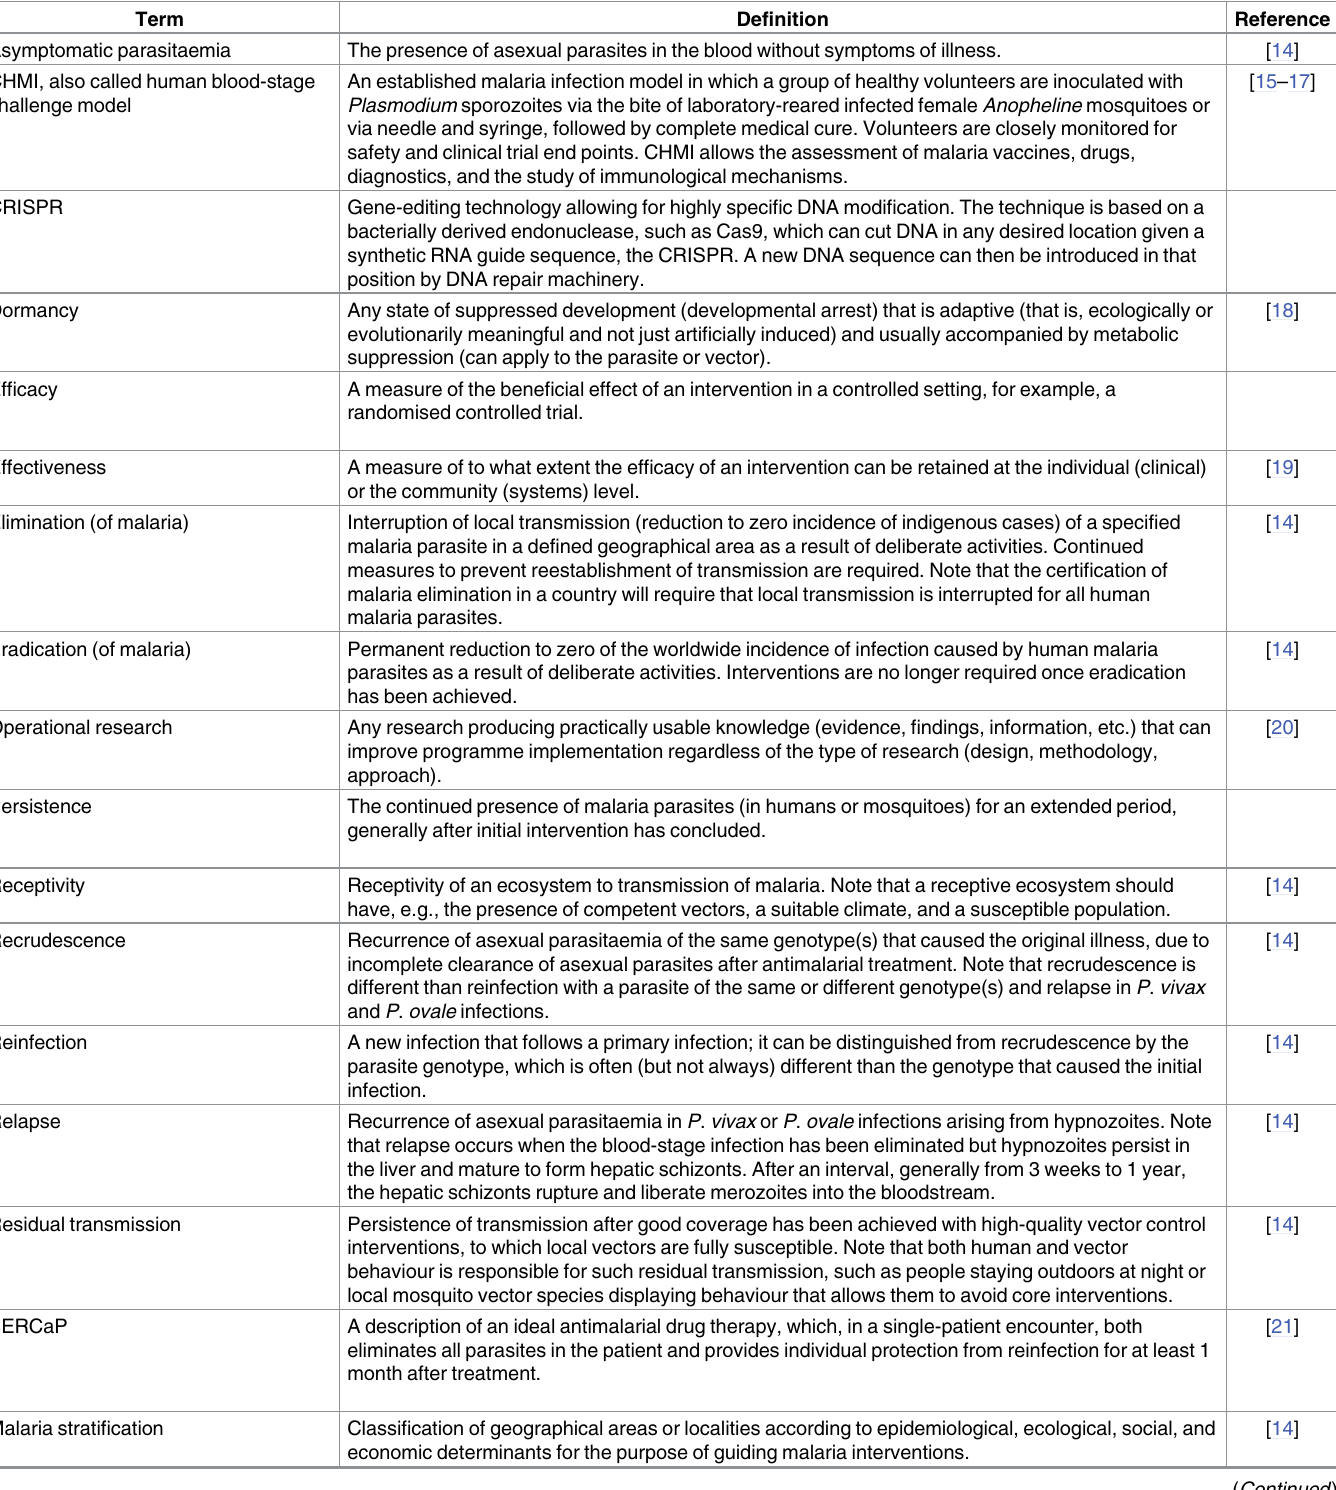
Table 1. Glossary of terms. The meaningof the terms used in the malERA Refresh series are describedhere. The sources of the definitions are referenced; where no reference is cited, the authors of this paper providedthe definition. Term Definition Asymptomatic